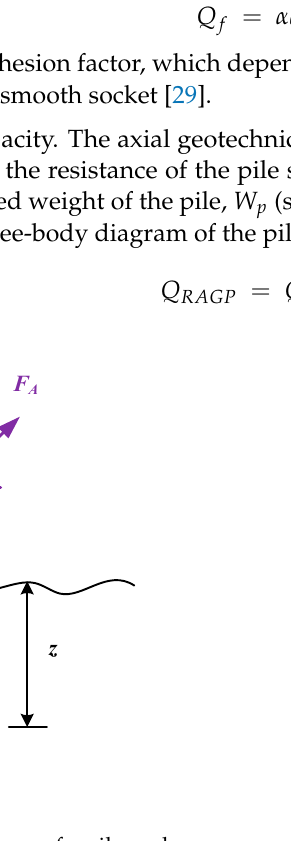
Figure 4. Free ‐ body diagram of a pile anchor. Figure 4. Free-body diagram of a pile